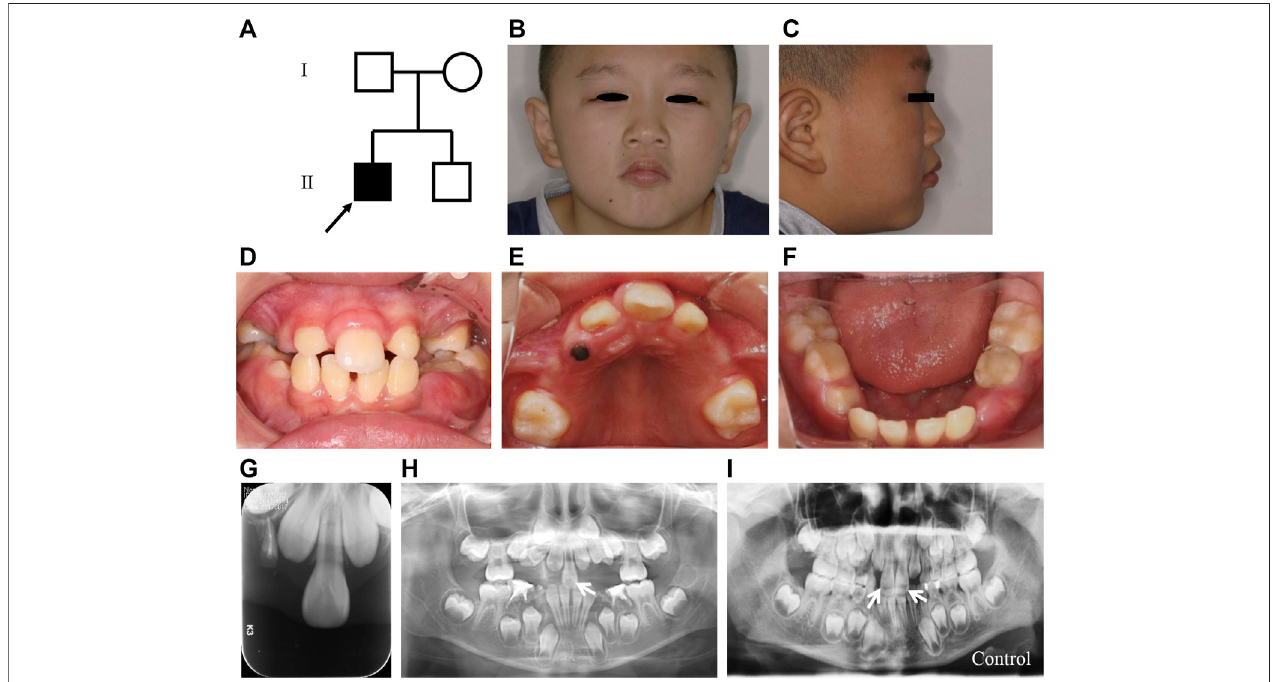
FIGURE1| ClinicalcharacteristicsoftheSMMCIpatientinthepresentstudy. (A) PedigreeoftheSMMCIpatient.Malesarerepresentedbysquaresandfemalesby circles. Filled symbols indicate affected individuals, and open symbols indicate those not affected. The arrow indicates the proband. (B,C) Frontal view (B) and lateral view (C) of the proband. (D – F) Intraoral photographs of the proband. (G) Periapical fi lm of the proband. (H) Panoramic radiograph of the proband, the white arrow indicates the SMMCI tooth. (I) Panoramic radiograph of the normal control. White arrows indicate the normal maxillary